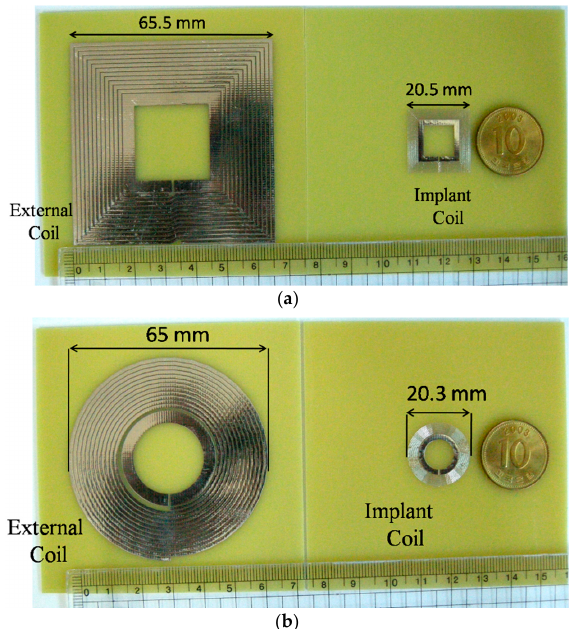
Figure 13. Coil dimension. ( a ) Square coil. ( b ) Circular coil. Table 4. Electrical Specification.